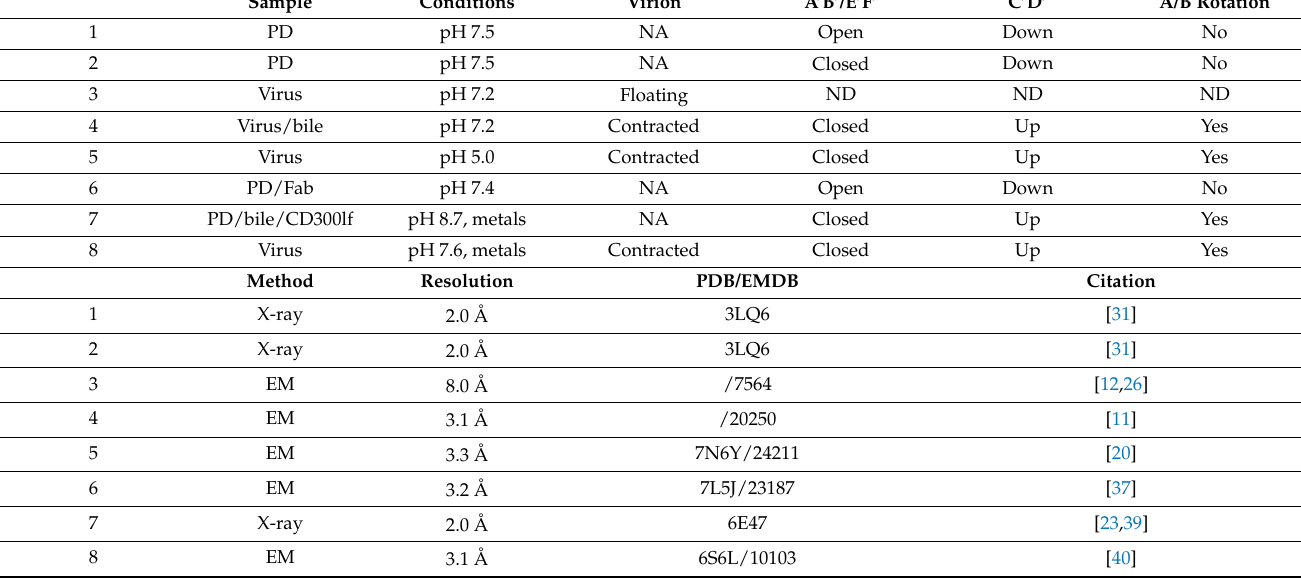
Table 1. Summary of MNV structures in various conditions. In this table, ‘PD’ denotes that the structure was of the isolated P domain, while ‘virus’ is used when the whole virus structure was determined. For the experiments using the whole virion, it is noted whether the P domains are in the ‘expanded’ (floating) or ‘contracted’ (affixed to the shell) states. Also noted is whether the A’B’/E’F’ loops are splayed apart (open) or tightly associated (closed). Also noted is whether the C’D’ loop is in the up or down position. The second part of the table denotes how the structures were determined, the resolution, and the associated database information. NA in this table is ‘not applicable’ since the structure was of the isolated P domain and not the whole virus. ND is ‘not determined’ because the structure was of low